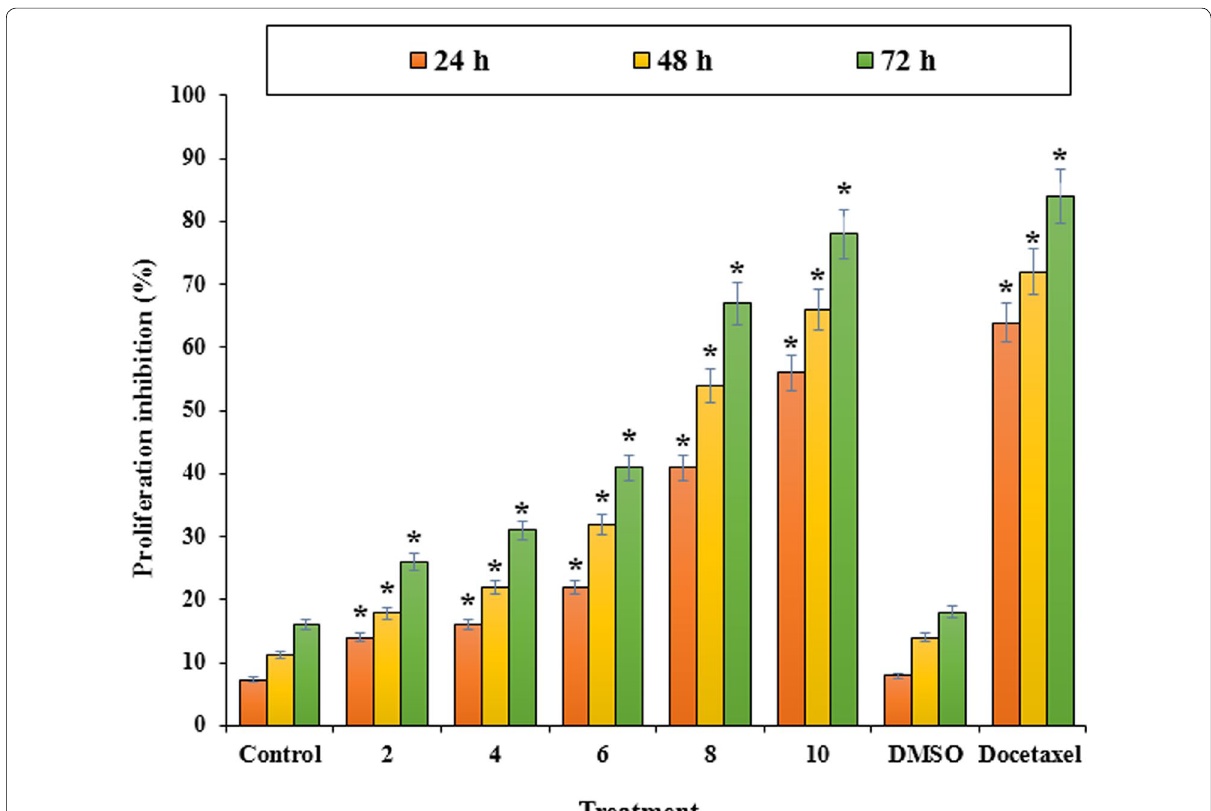
Fig. 4 The effect of L. usitatissimum extract on the proliferation inhibition of LNCaP cells. The percentage was measured by MTT assay. LNCaP cells were treated with different concentrations of the extract for 24, 48, and 72 h. *Indicate the significant difference ( p < 0.01) between experimental